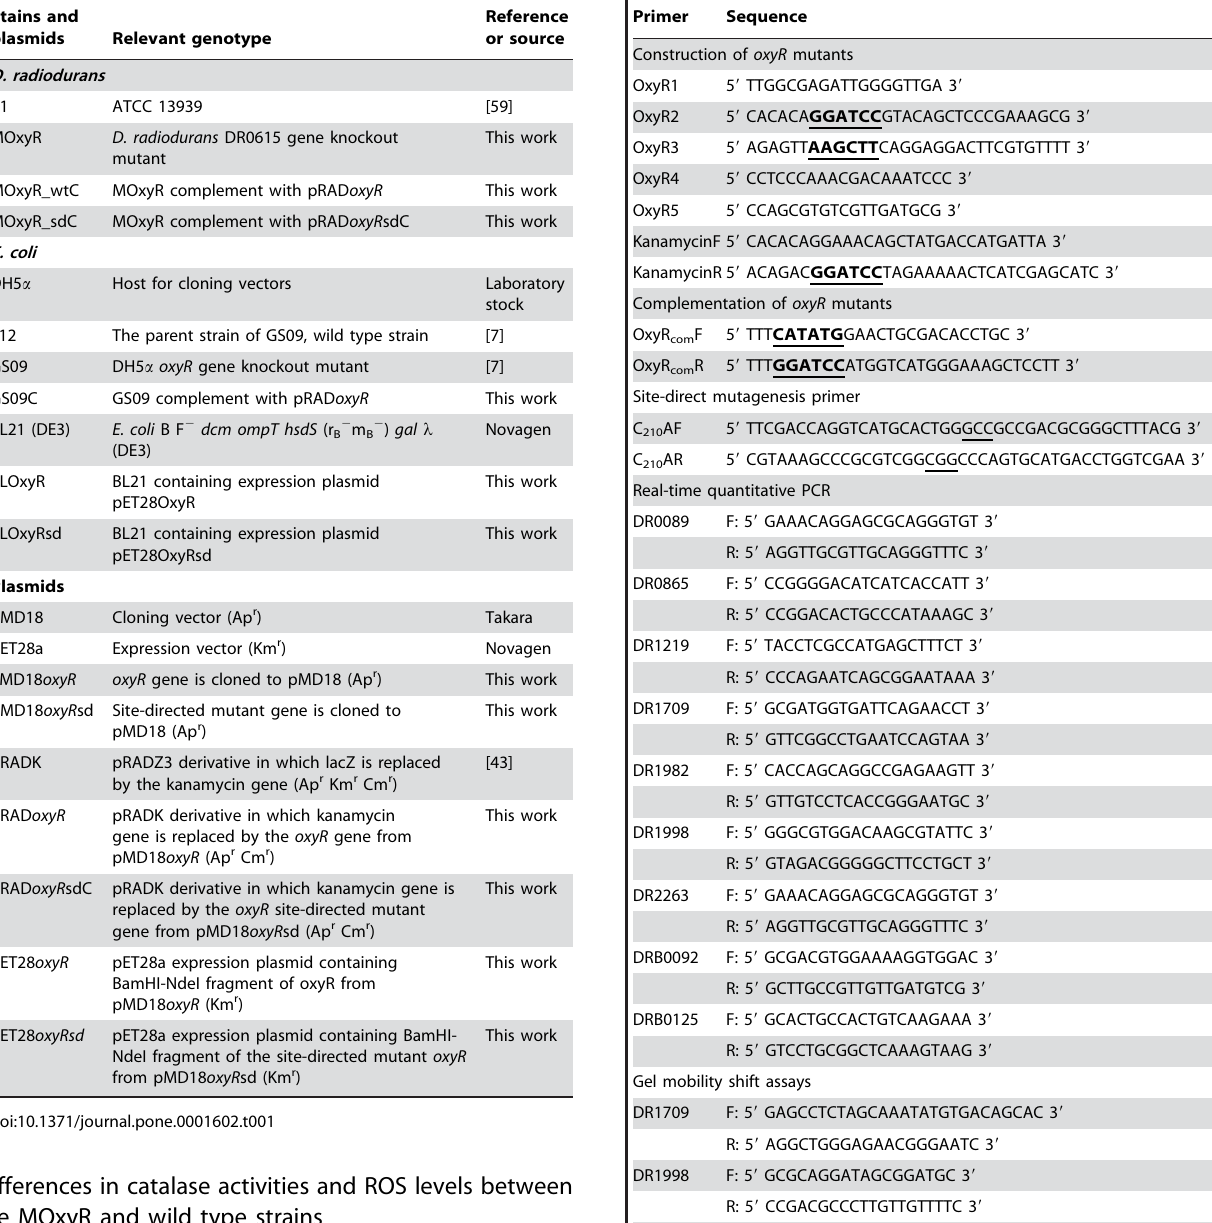
Reference or source